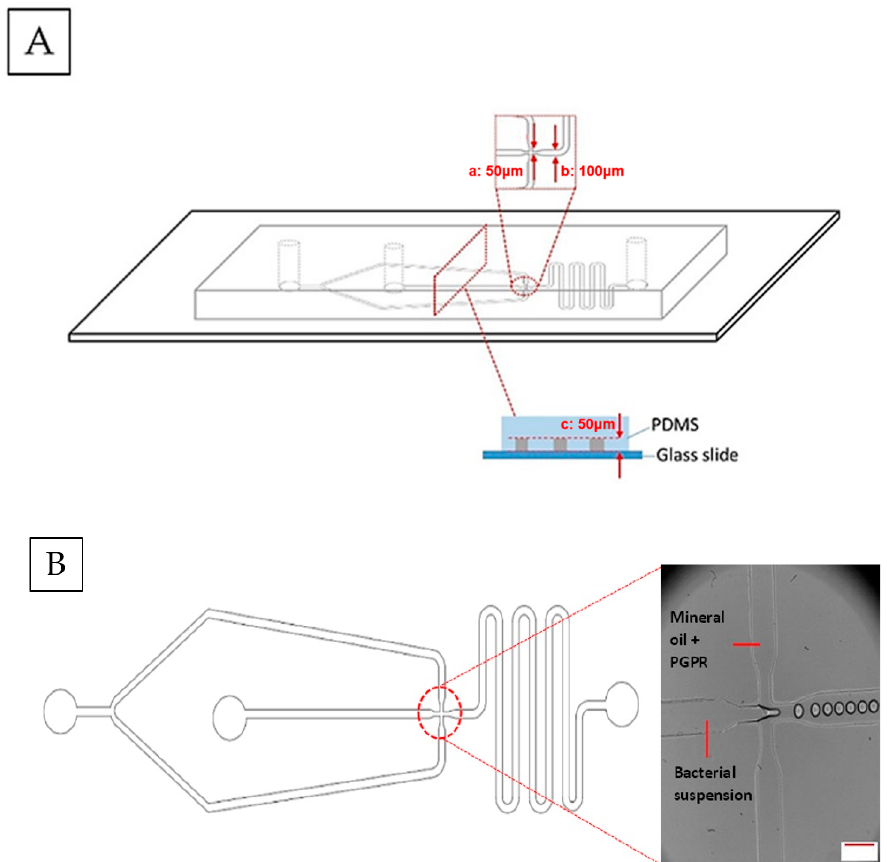
Figure 1. ( A ) Flow-focusing microfluidic device fabrication for W/O droplet generation: width at the junction (a): 50 µ m, width at the exit channel (b): 100 µ m and depth (c): 50 µ m. ( B ) Monodispersed W/O droplet formation whereby W/O droplets were formed at the flow-focusing junction (in the circle). Scale bar represents 100 µ m.